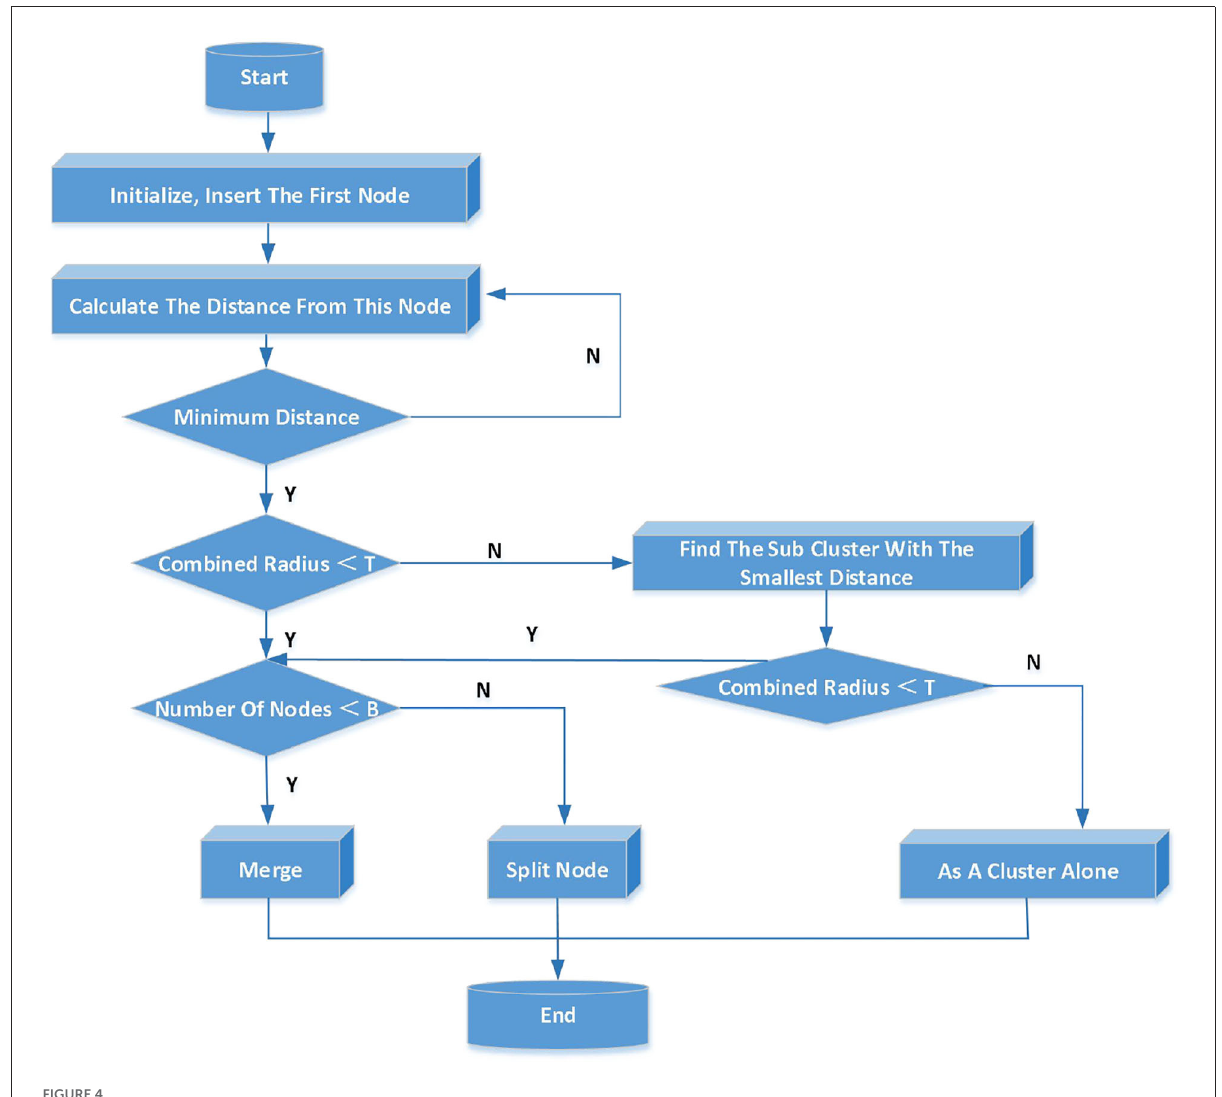
FIGURE4 BC-BIRCH algorithm